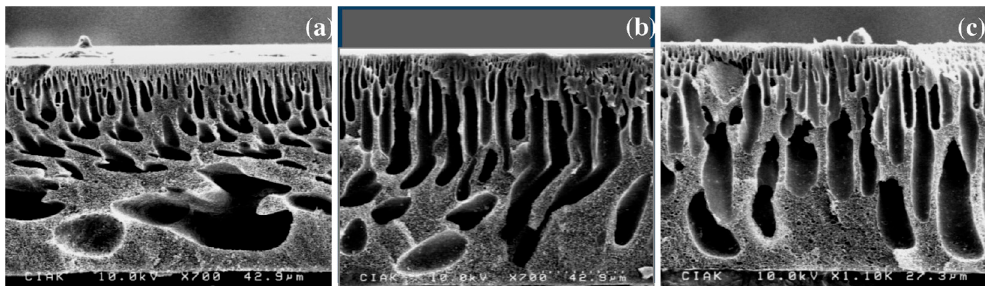
Figure 1. Scanning electron microscope (SEM) images of the cross section of the ( a ) base membrane, ( b ) 0.1 wt.% and ( c ) 0.5 wt.% polydopamine-multiwalled carbon nanotube/polysulfone (Pdop-MWNT/PSF) membranes. (Reproduced with permission after [30]).